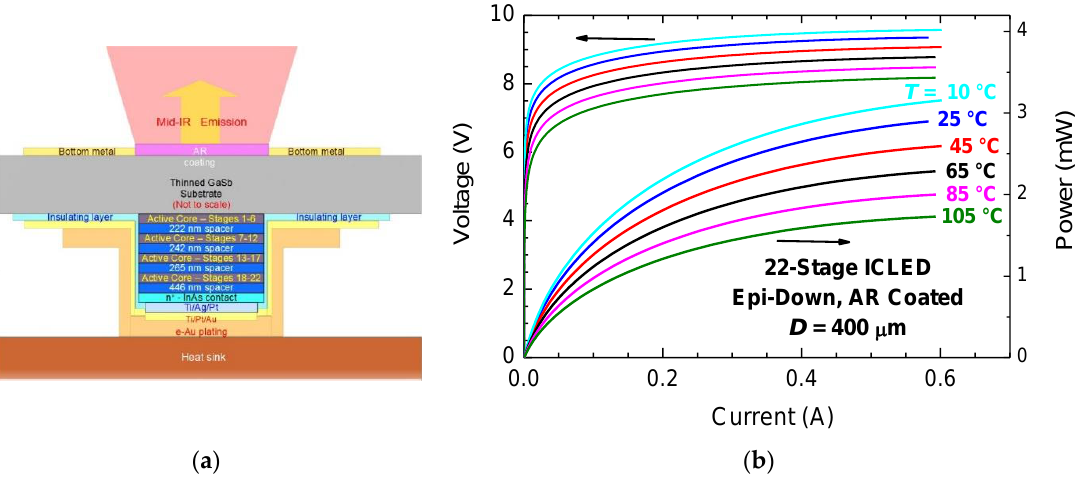
Figure 20. ( a ) Schematic of an epi-side-down mounted ICLED mesa with 22 active stages split into four groups positioned at antinodes of the optical field reflected from the metal contact; ( b ) Cw L − I − V characteristics for an epi-down-mounted ICLED with mesa diameter 400 µ m at six di ff erent temperatures ranging from 10 ◦ C to 105 ◦ C